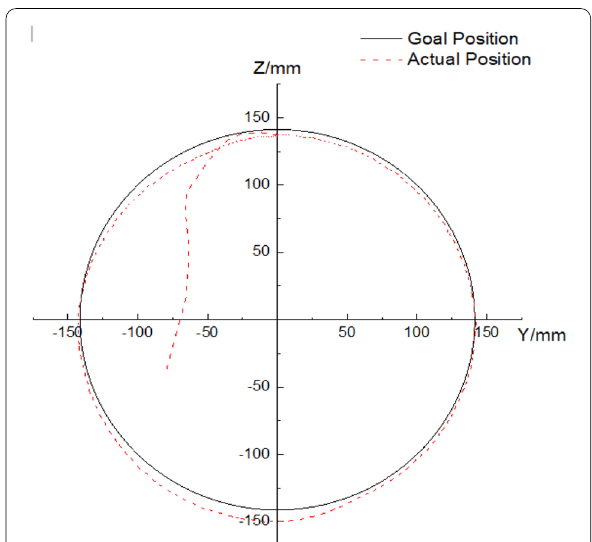
Figure 11 Tracking trajectory of the